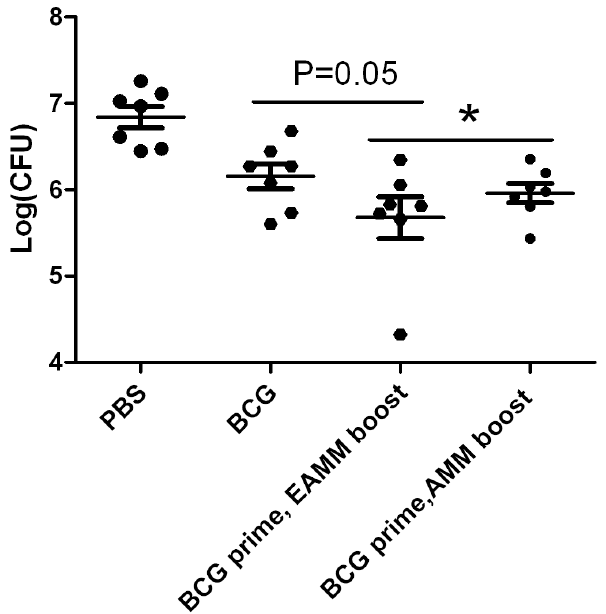
Figure 6. Protective efficacy against virulent M. tuberculosis H37Rv infection in mice primed with BCG and boosted with EAMM or AMM. Mice were primed with BCG and boosted by EAMM/AMM two times at the 12th and 14th week. Ten weeks after boosting, mice were challenged with 5×10 5 CFU of M. tuberculosis H37Rv. Six weeks after challenge the bacterial load in the lungs was determined. Results are presented as mean ± SD, n = 7. * p < 0.05 vs. PBS. doi: